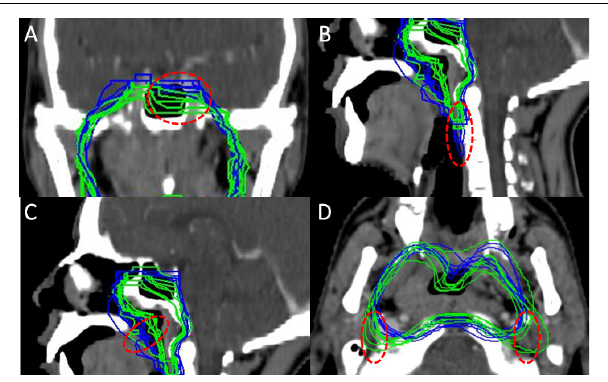
FIGURE 2 | Some controversies among all contouring. (A) Coverage of pterygoid sinus and cavernous sinus at contra-lateral side. (B) Caudal border on posterior pharyngeal wall. (C) Coverage of air cavity. (D) Coverage of posterior space of styloid